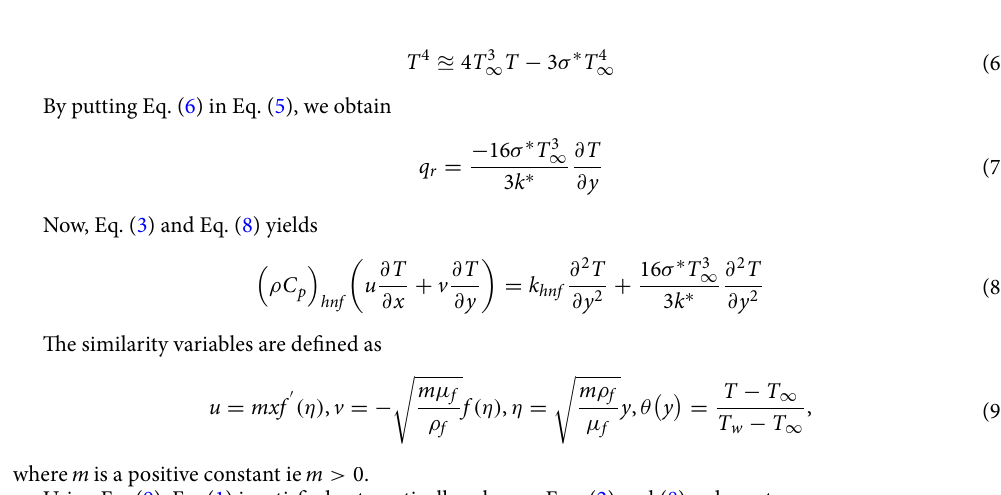
Al 2 O 3 / H 2 O or